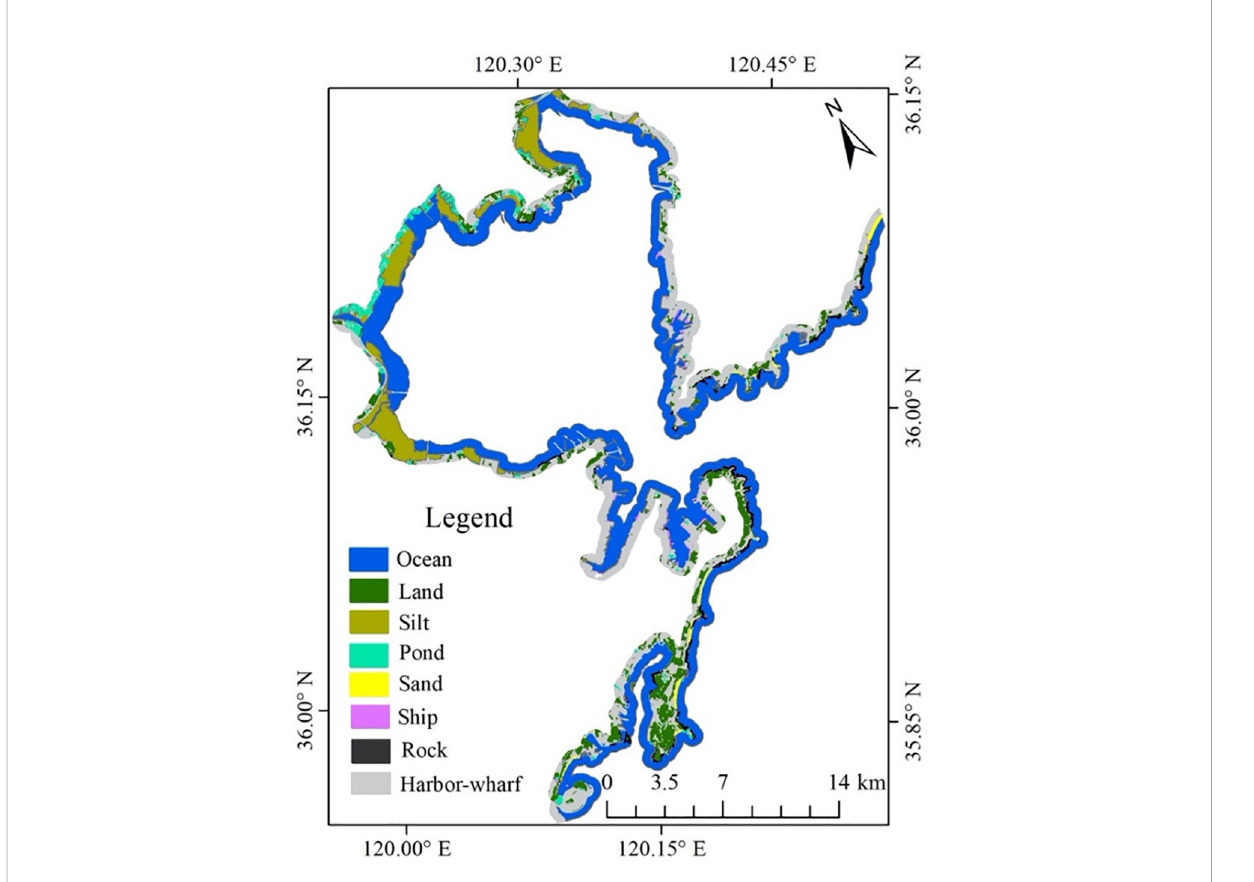
FIGURE 7 Classi fi cation result of coastal features of Jiaozhou